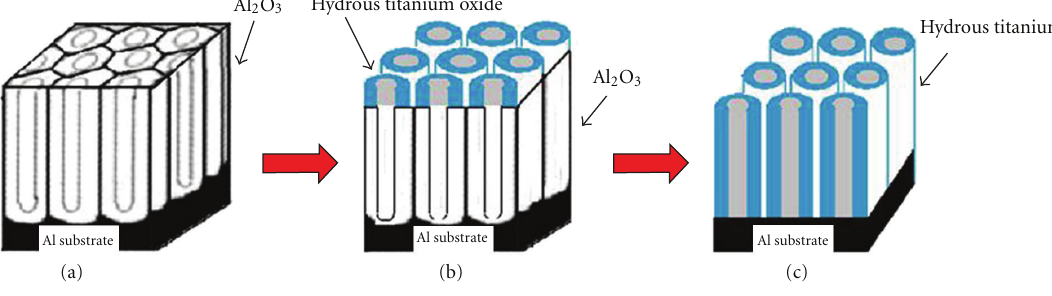
Figure 2: Schematic diagram of the formation of the titania nanohole array: (a) before deposition, (b) during deposition, and (c) after deposition